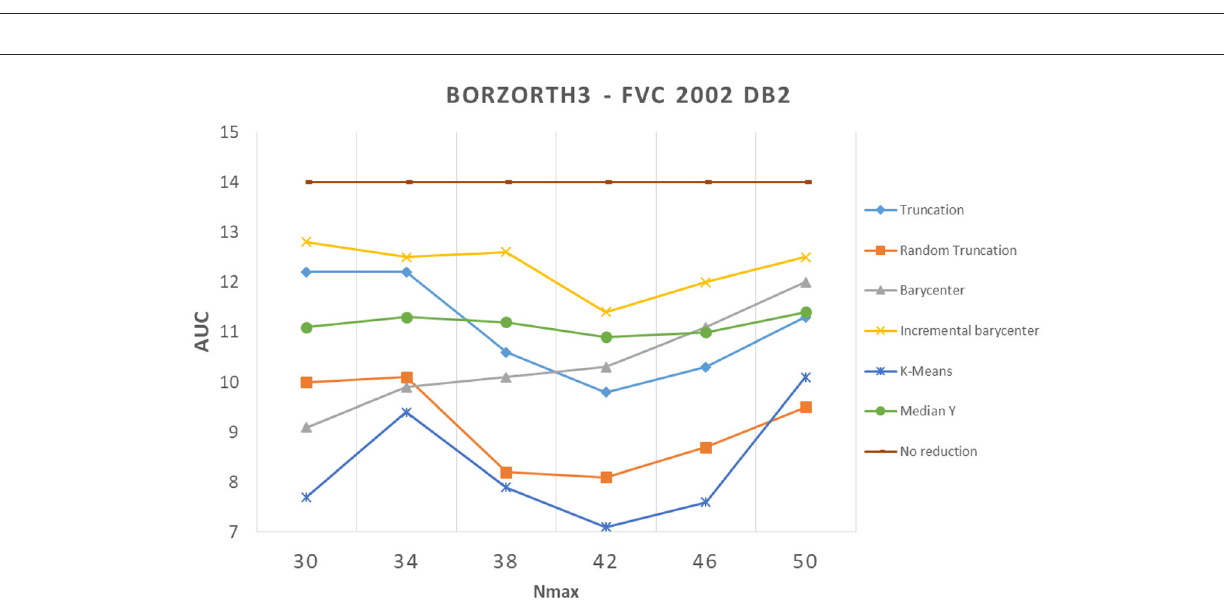
FIGURE8 Comparison of template reduction methods on the FVC 2002 DB2 with the Bozorth3 matching